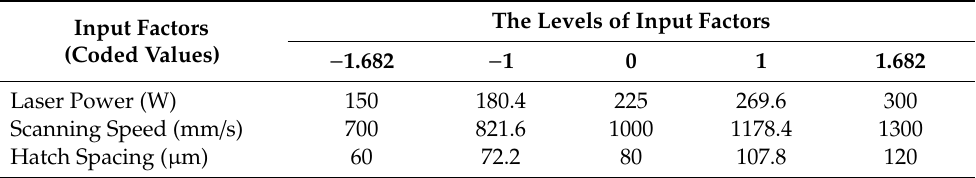
Table 2. Di ff erent levels and coded values of processing parameters in the RSM (response surface method).